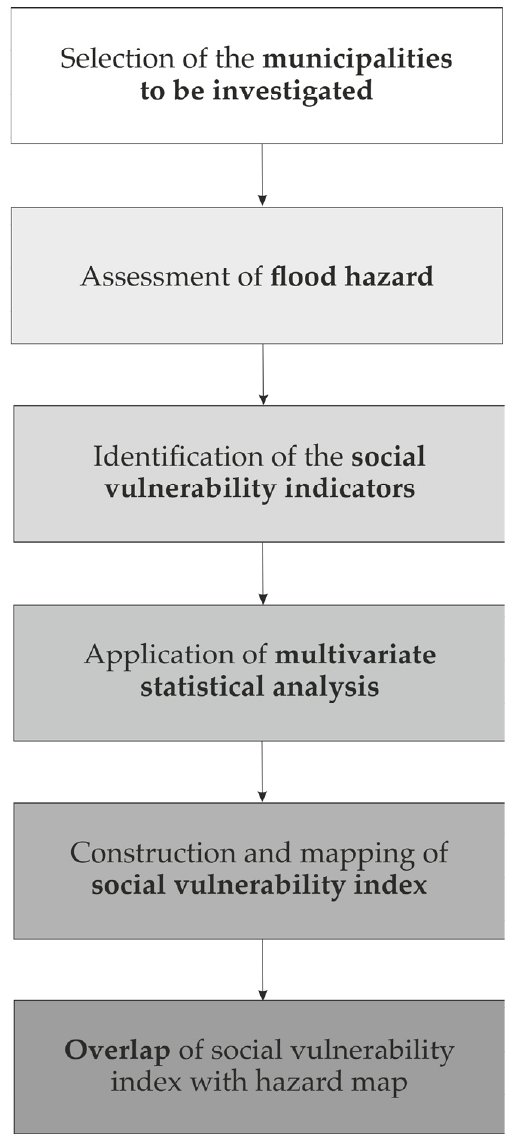
Figure 2. Methodological workflow followed to combine social vulnerability and flood